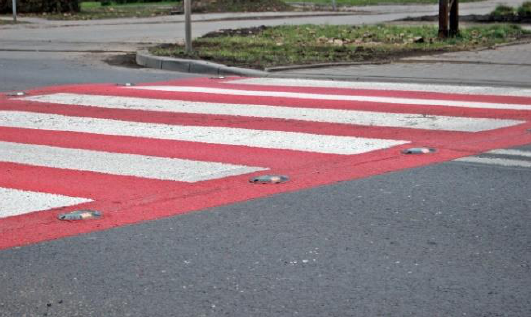
Figure 11. Advanced design of pedestrian crossings: active crossing equipped with ‘cat’s eyes’. The use of an unusual installation from Qu é bec in Canada could turn out to be innovative and it consists of yellow panels that imitate the stripes on a pedestrian crossing.